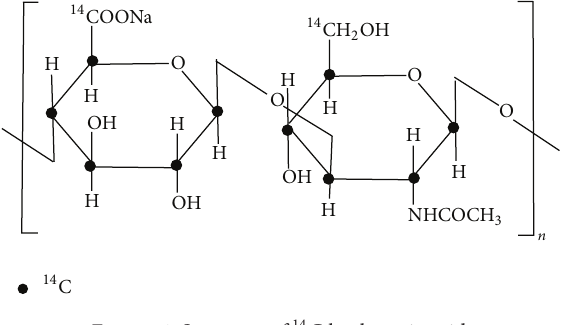
Figure 1: Structure of 14 C hyaluronic acid.